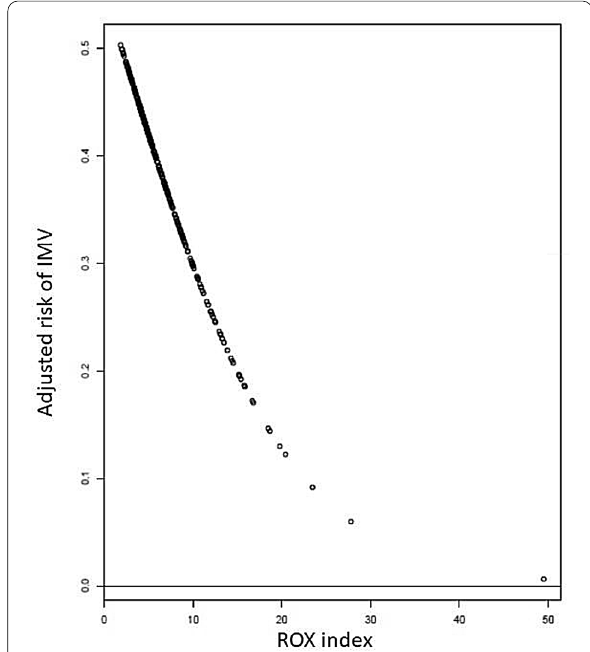
Fig. 2 Probability of intubation according the ROX